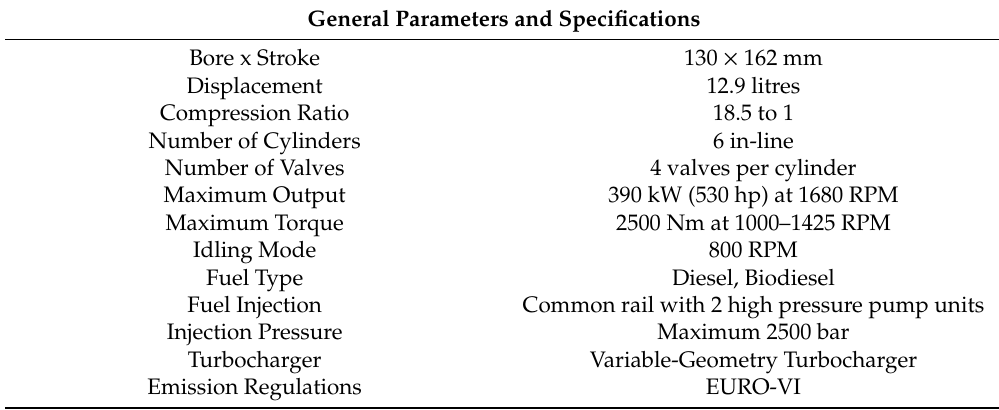
Table 1. General parameters and specifications of the research diesel